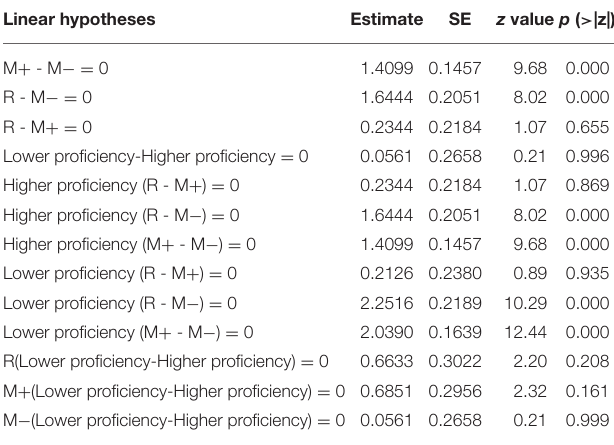
TABLE 5 | Tukey post-hoc test of accuracy in semantic relatedness judgment task.